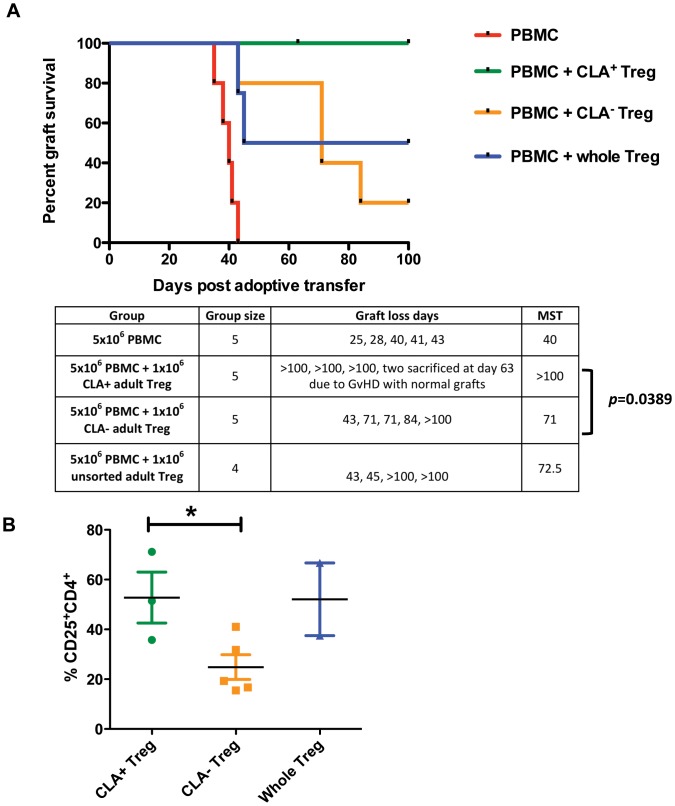
Skin-homing CLA+ Treg are more effective at preventing allograft destruction than CLA
−
Treg.
(A) APB-derived Treg were sorted into CLA+ and CLA− subpopulations and adoptively transferred together with non-autologous PBMC at a 5∶1 ratio of PBMC to Treg into mice previously transplanted with a human skin allograft. A further group of mice received unsorted APB-derived Treg. While CLA− Treg treatment resulted in an MST of 71, treatment with CLA+ Treg significantly prolonged skin allograft survival to beyond 100 days (p = 0.0389). Mice receiving unsorted Treg achieved a similar MST to those receiving CLA− Treg (72 days, p = 0.1827). (B) In mice treated with CLA+ Treg, a higher frequency of CD4+CD25hi cells was detected within the graft on day 100 compared to mice treated with CLA− Treg (p = 0.031).